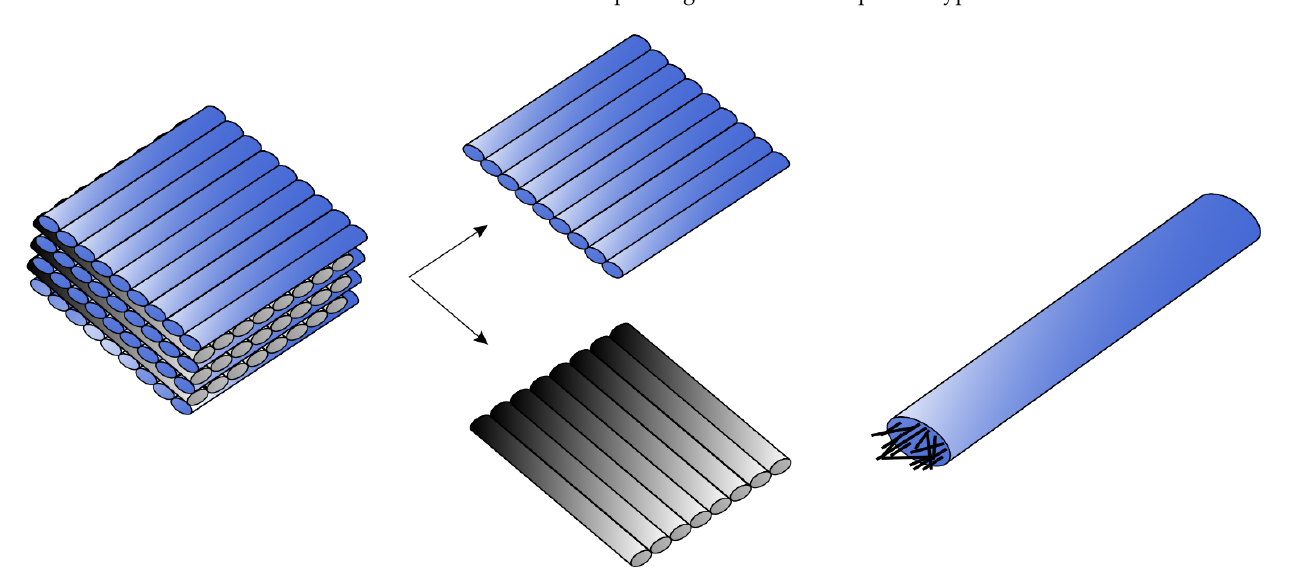
Figure 1. Fundamental scheme of fused filament fabrication printer. The controlled deposition of material into structure allows printing of various infill pattern types.